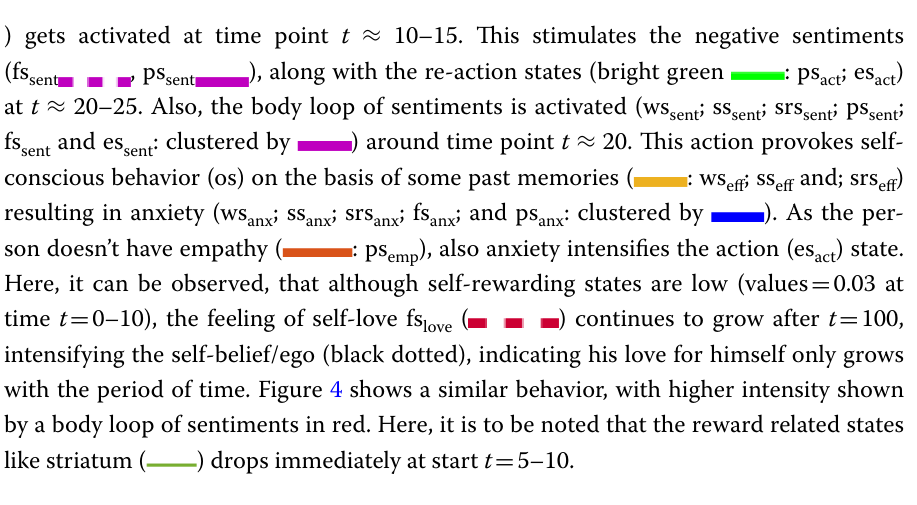
0 and ws nf 1: reaction is extreme = =